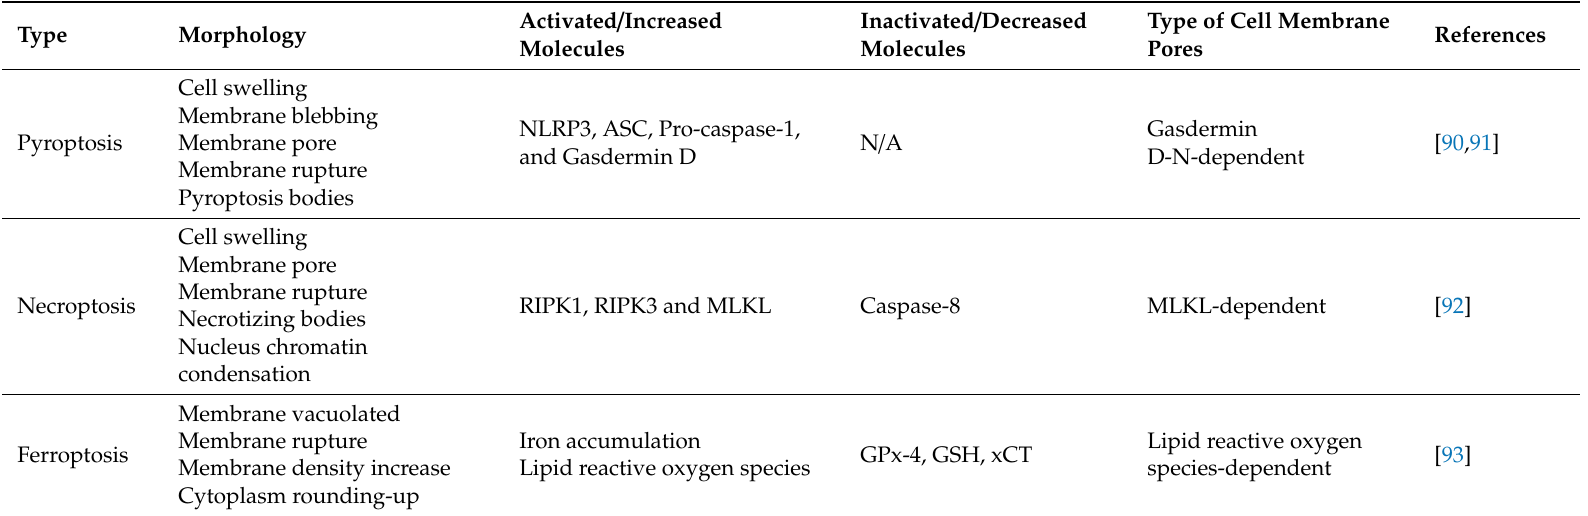
Table 1. Comparison among Novel Programmed Cell Death